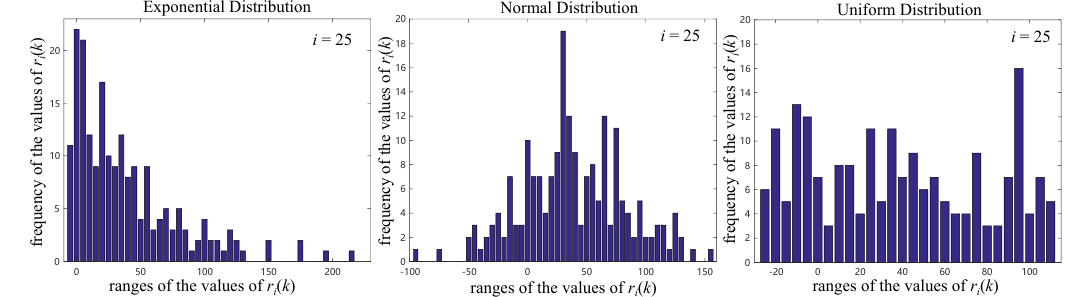
Figure 14. Three different distributions of r i ( k ) in node 25.